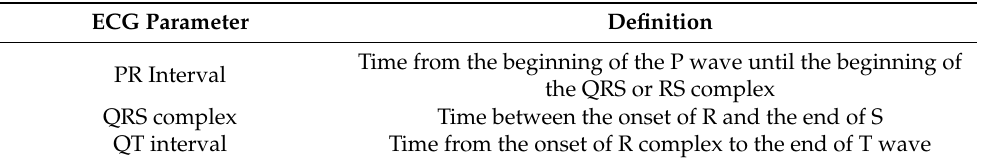
Table 1. Electrocardiography (ECG)